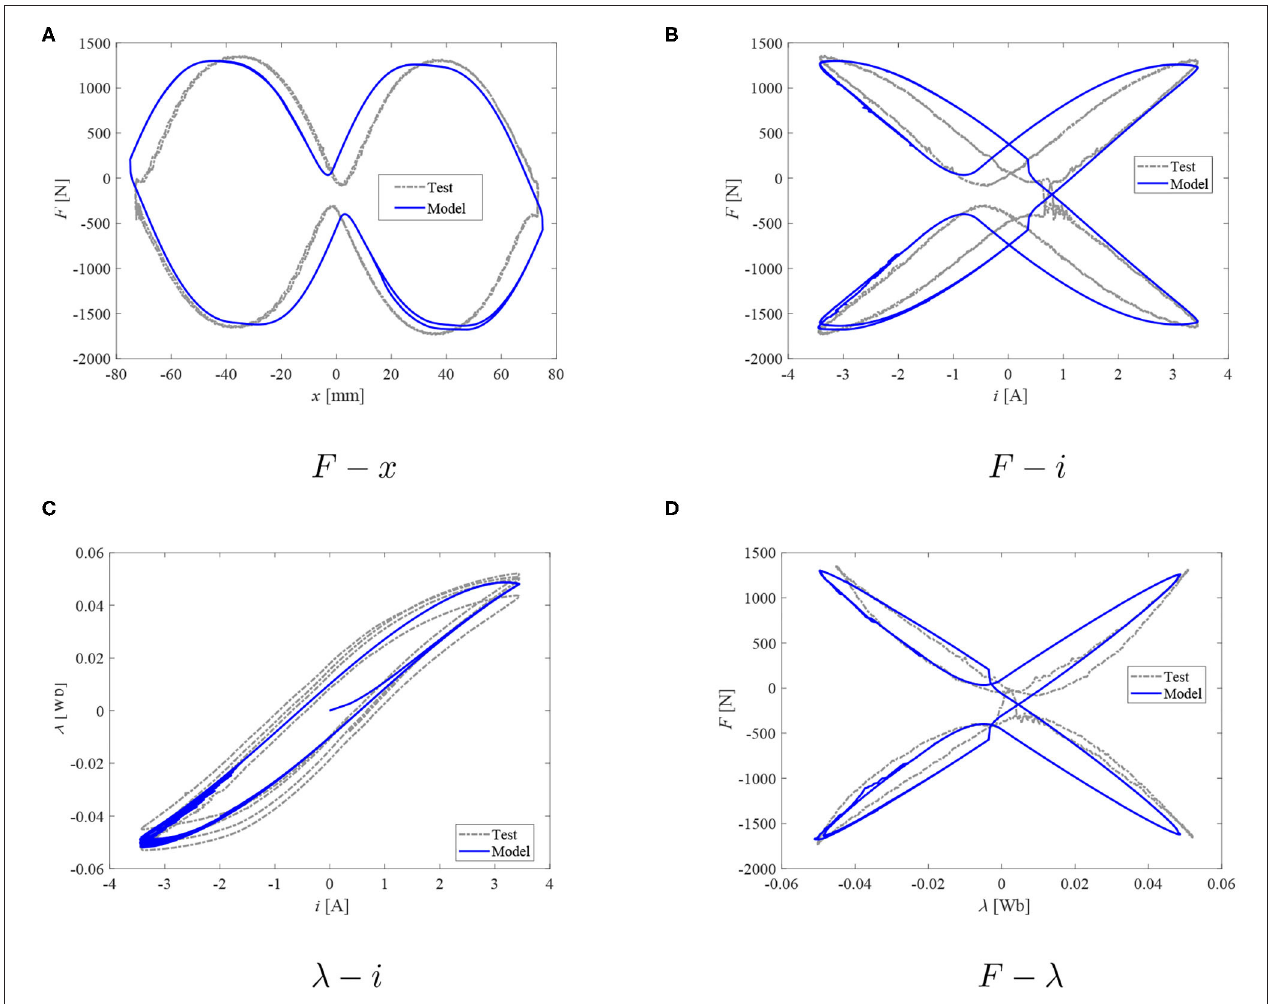
FIGURE 13 | Damper model: measured force and reconstructed flux vs. model data; I = 3.5 A. (A) F − x . (B) F − i . (C) λ − i . (D) F − λ